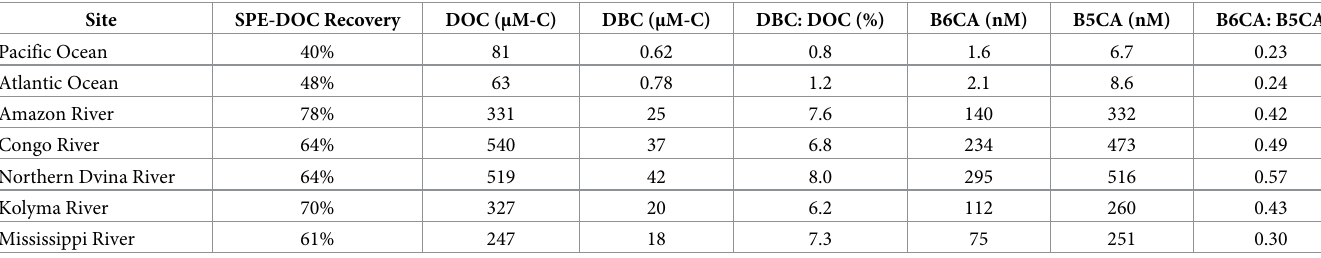
Table 1. A subset of DBC data originally published by Wagner et al.